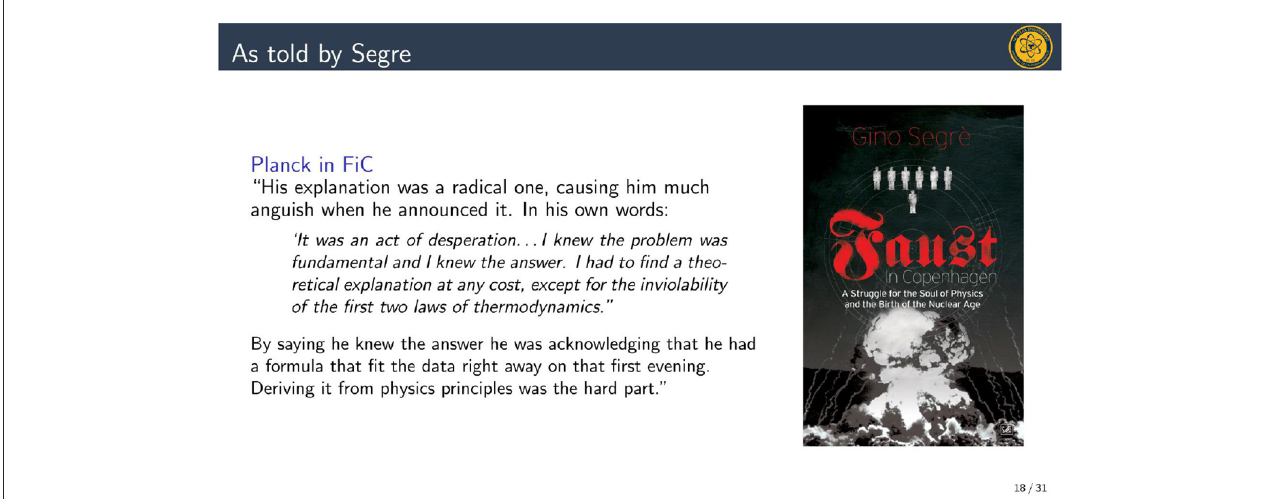
FIGURE3 Planck in Faust in Copenhagen . Lecture W2L3.